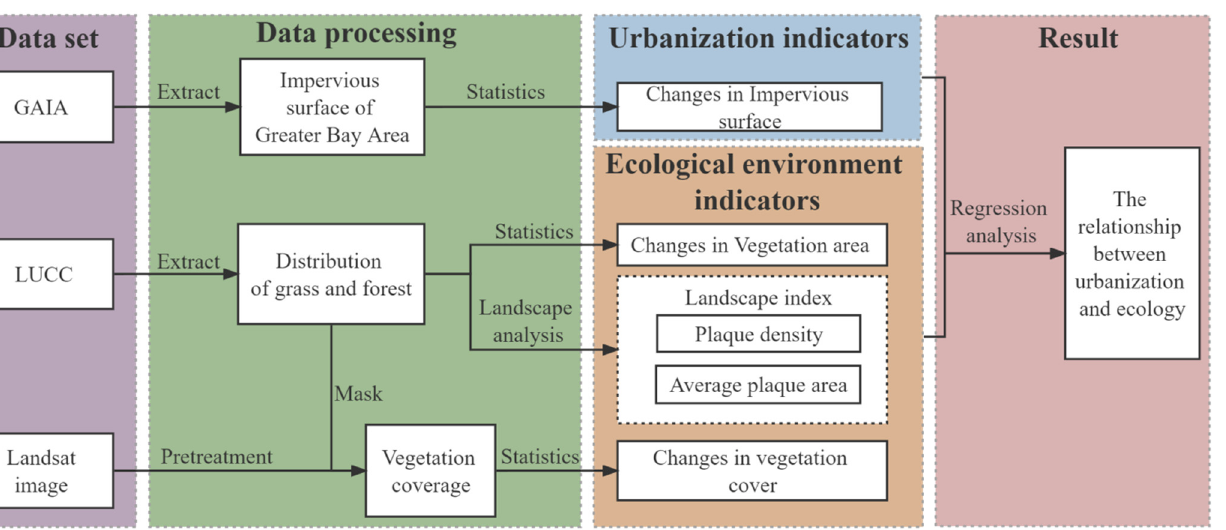
Figure 3. Impervious surface area of the Greater Bay Area.